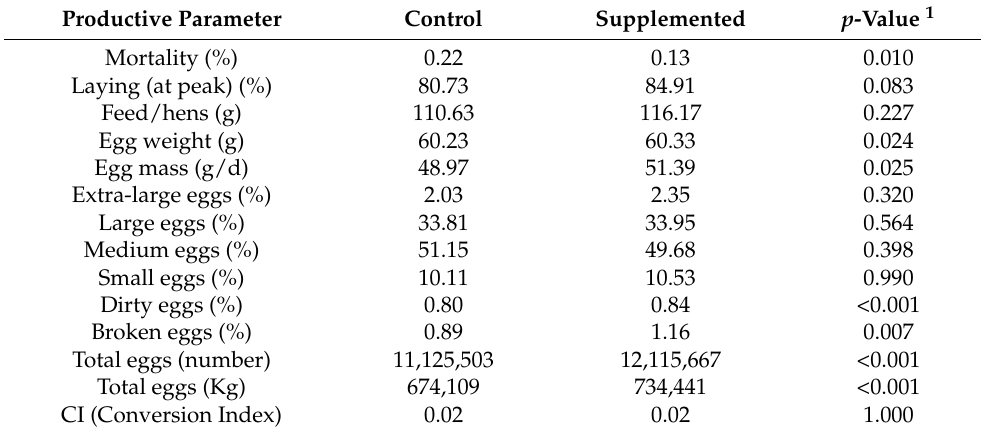
Table 5. Production performance of control and supplemented group.